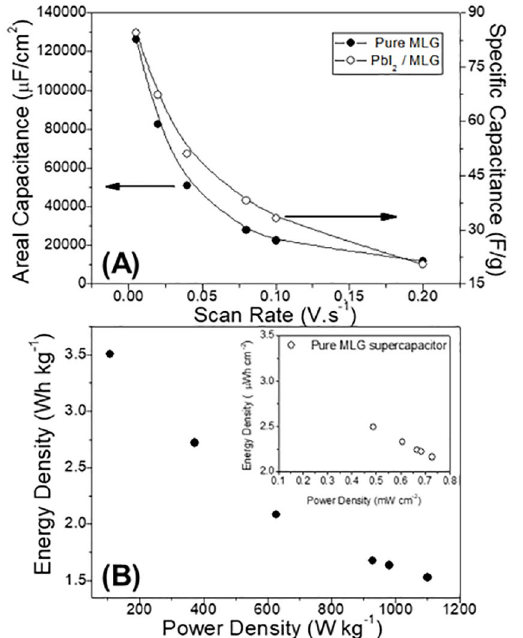
Figure 5. (a) Areal capacitance (capacitance per area unit) for Pure MLG supercapacitor versus scan rate (at left) and specific capacitance (per mass) versus scan rate for PbI -NPs/MLG supercapacitor (at 2 -NPs /MLG supercapacitor and right) and (b) Ragone plot for PbI 2 for pure MLG in inset. The lines linking the experimental points are only guide for eyes.